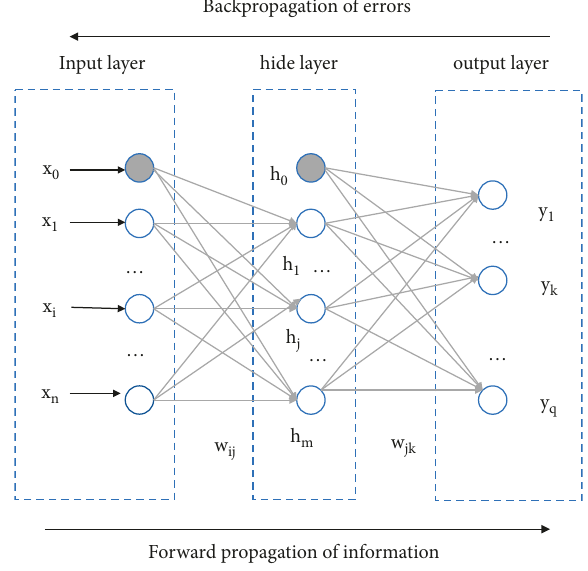
Figure 1: 3-layer BP neural